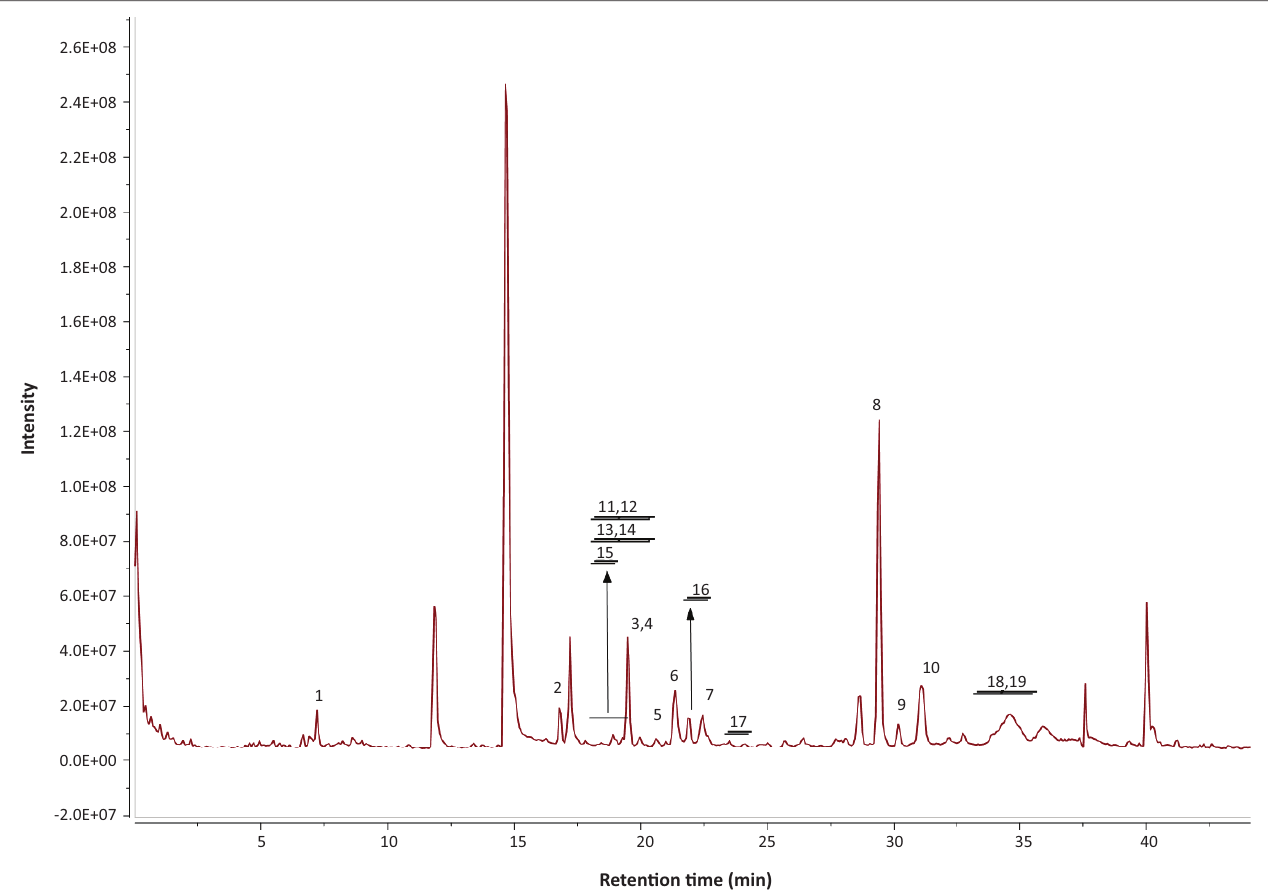
FIGURE 7: Total ion chromatogram for D. filix-mas (DF) showing identified metabolites (1–10) and unidentified but detected metabolites (11–19). The identification, molecular formula, molecular weight, mass to charge ratio (m/z) and retention time in min (RT) are indicated in Tables 1 and